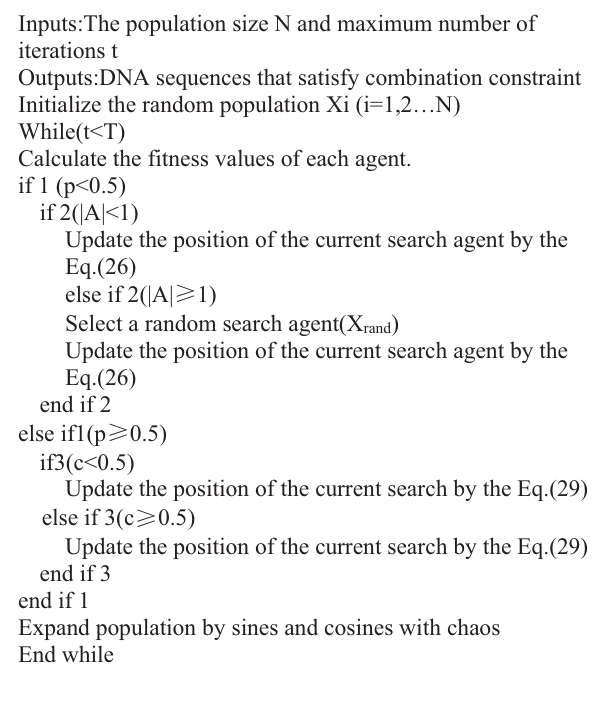
FIGURE 4 | Pseudo-code of the ICW optimization algorithm.